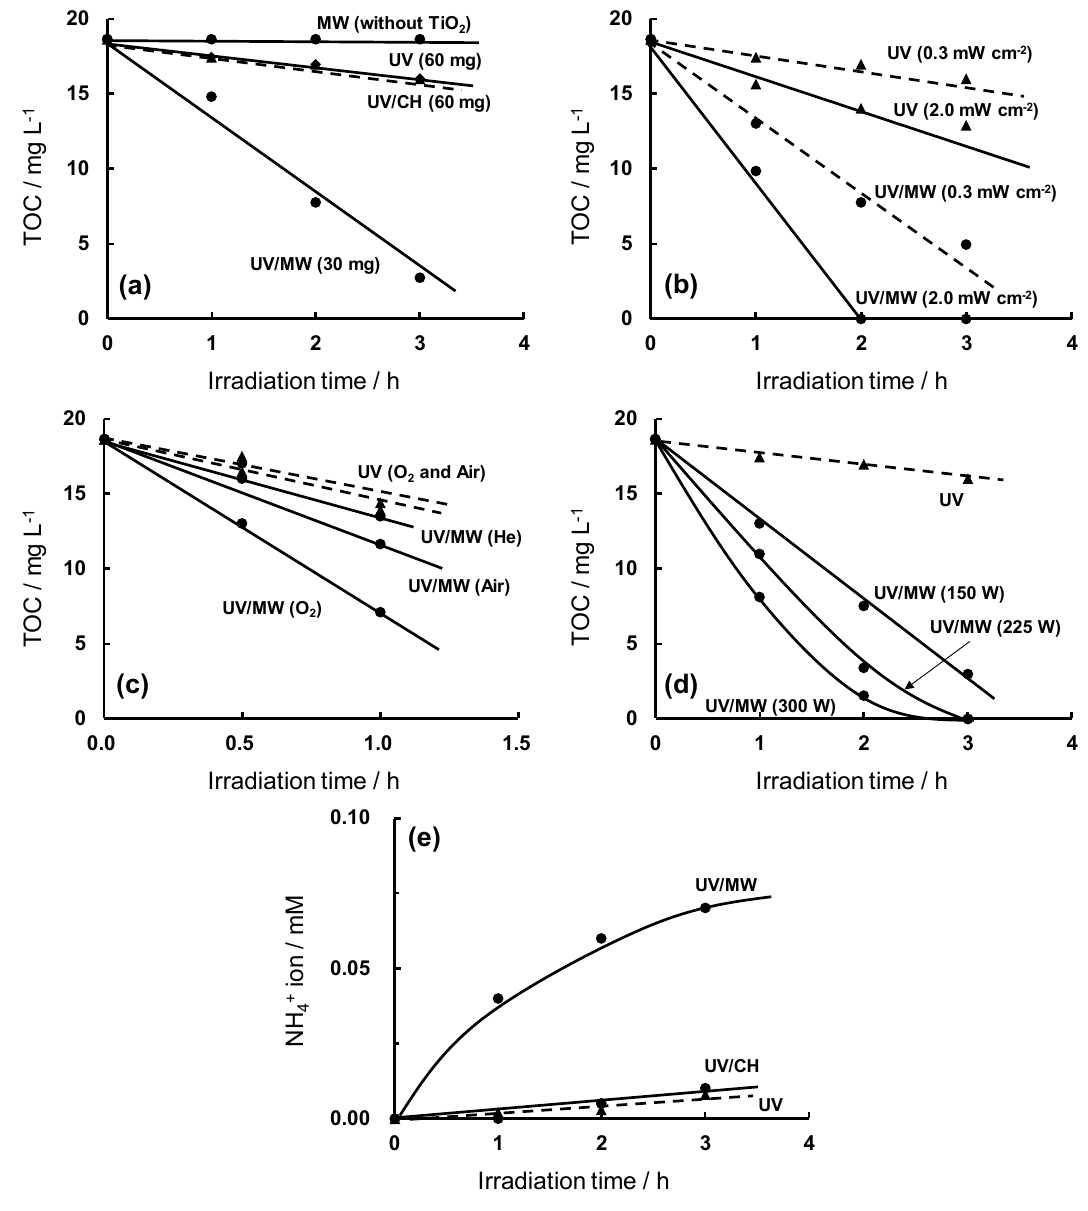
Figure 3. ( a ) Decrease of total organic carbon (TOC) in the decomposition of RhB solution (initial TOC concentration, 18.6 mg·L − 1 ; 30 mL) by MW (without TiO 2 ), UV (60 mg), UV/CH (60 mg) and UV/MW (30 mg); ( b ) Temporal evolution of the decrease of TOC during the degradation of RhB solution (0.050 mM, 30 mL) at a radiance of 0.3 and 2.0 mW·cm − 2 ; ( c ) Decrease of TOC values for the influence of different added gases on the degradation of RhB (0.050 mM); ( d ) Decrease of TOC for RhB solutions (0.050 mM, 30 mL) with TiO 2 loading (30 mg) by the UV/MW method (microwave applied power at 150 W, 225 W and 300 W); ( e ) Temporal evolution of the formation of NH 4+ ions in the decomposition of RhB (0.050 mM) using the UV, UV/CH and UV/MW methods; the radiance was 0.3 mW·cm − 2 . Reproduced from [10]. Copyright 2002 by the American Chemical